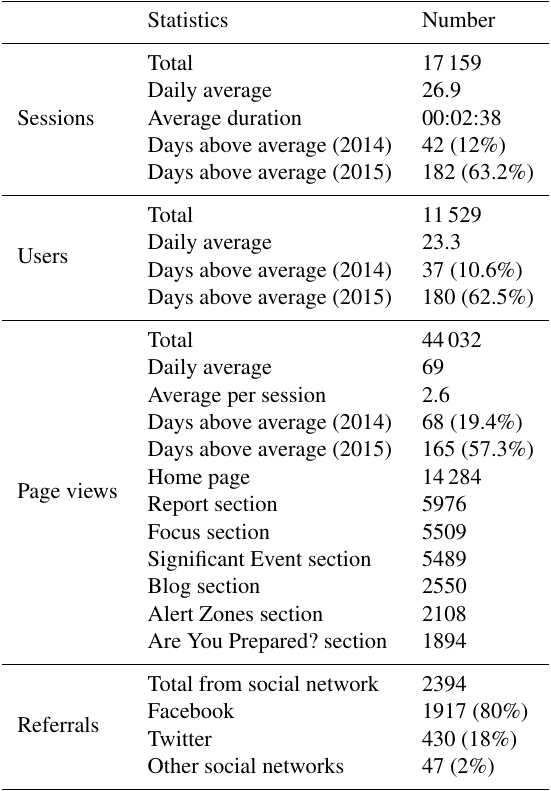
Table 1. POLARIS website general statistic for sessions, users, page views and referrals from social networks, calculated using Google Analytics